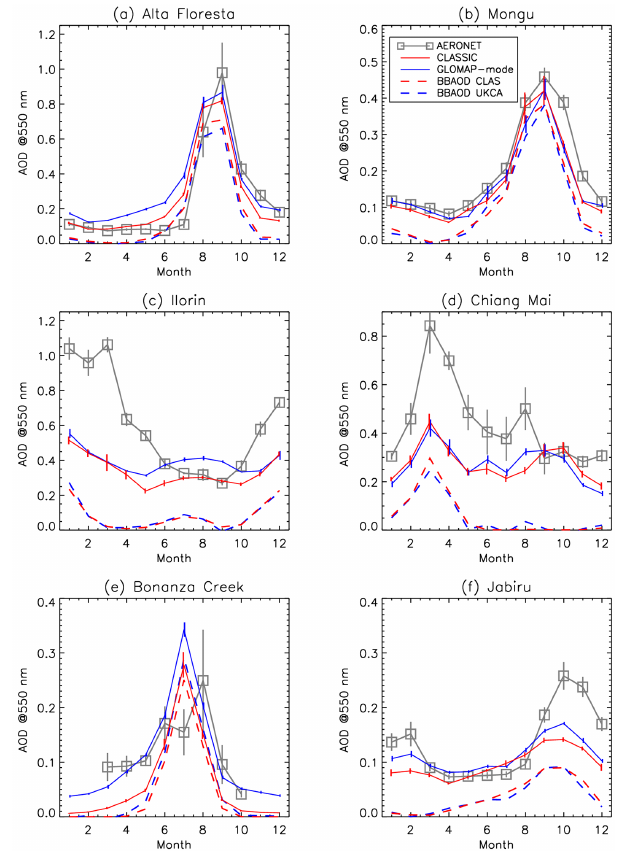
Figure 5. Monthly mean AOD at 550nm from six AERONET sites (grey squares), and the same locations from GLOMAP-mode (blue) and CLASSIC (red). The contribution to AOD from BBA is shown by dashed lines. Vertical lines show ± 1 standard